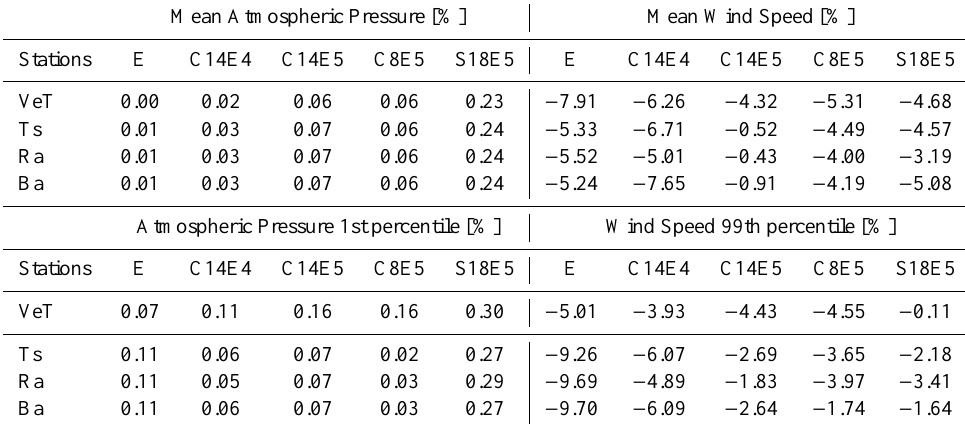
Table 2. Di ff erences between A1B scenario (2070–2100) and reference period (1960–1990) − 100(A1B − reference) / reference − for mean and 99th percentile values of atmospheric pressure (left panel) and wind speed (right